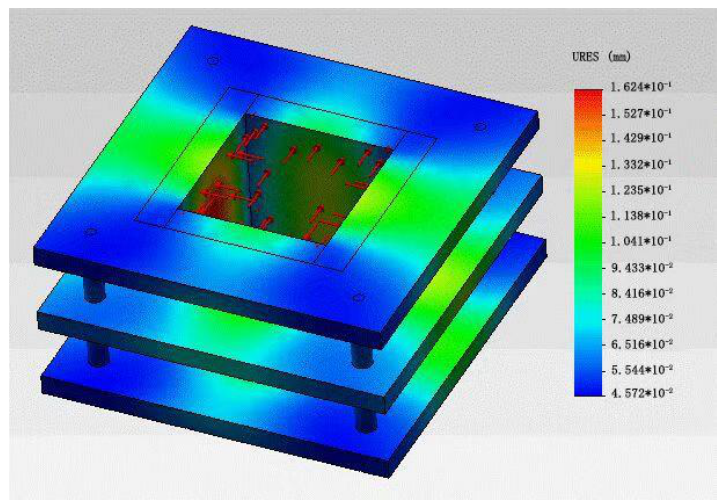
Figure 5. Deformation of the inner wall of the mould by finite element calculation.